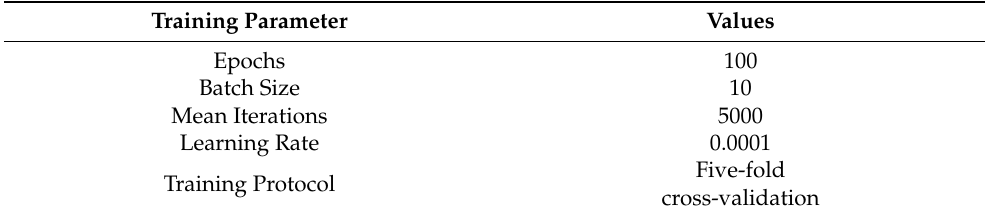
Table 4. Initial training parameters of CNNs.